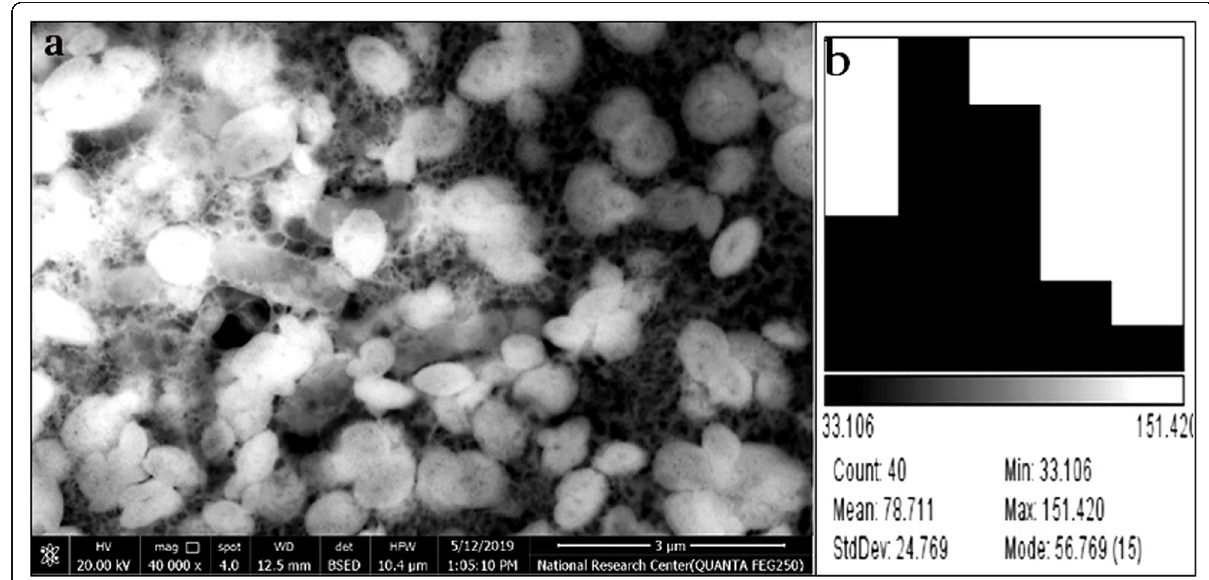
Fig. 5 Plantaricin-incorporated silver nanoparticles PL-SNPs. a The SEM micrographs of PL-SNPs. b Histogram data of particles dimensions (nm) PL-SNPs using